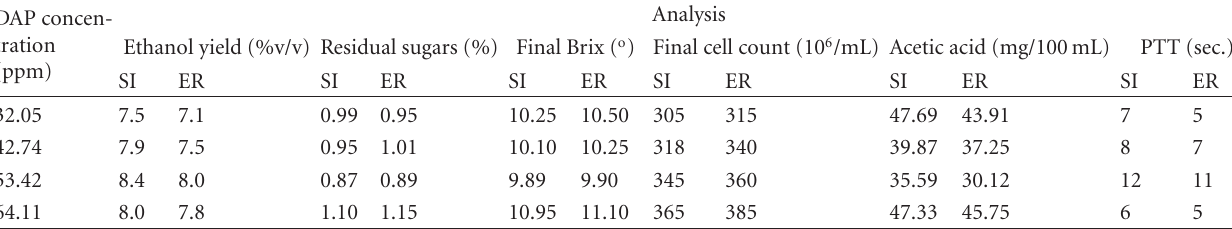
∗ SI: Saf-Instant and ER: Ethanol Red. Table 4: E ff ect of varying inoculum sizes on ethanol and acetic acid production by two commercial yeast strains ∗ using sugarcane molasses in fed-batch cultures.